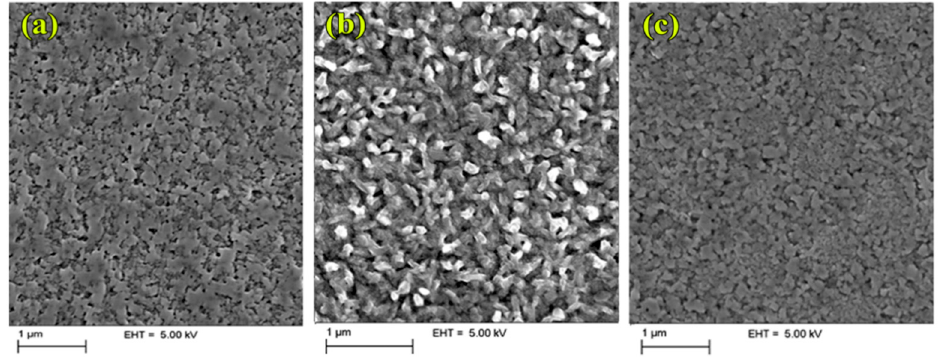
Figure 4. Top view SEM images of perovskite/starch crystals grown on Poly-TPD ( a ), PEDOT ( b ), and PTAA ( c ).